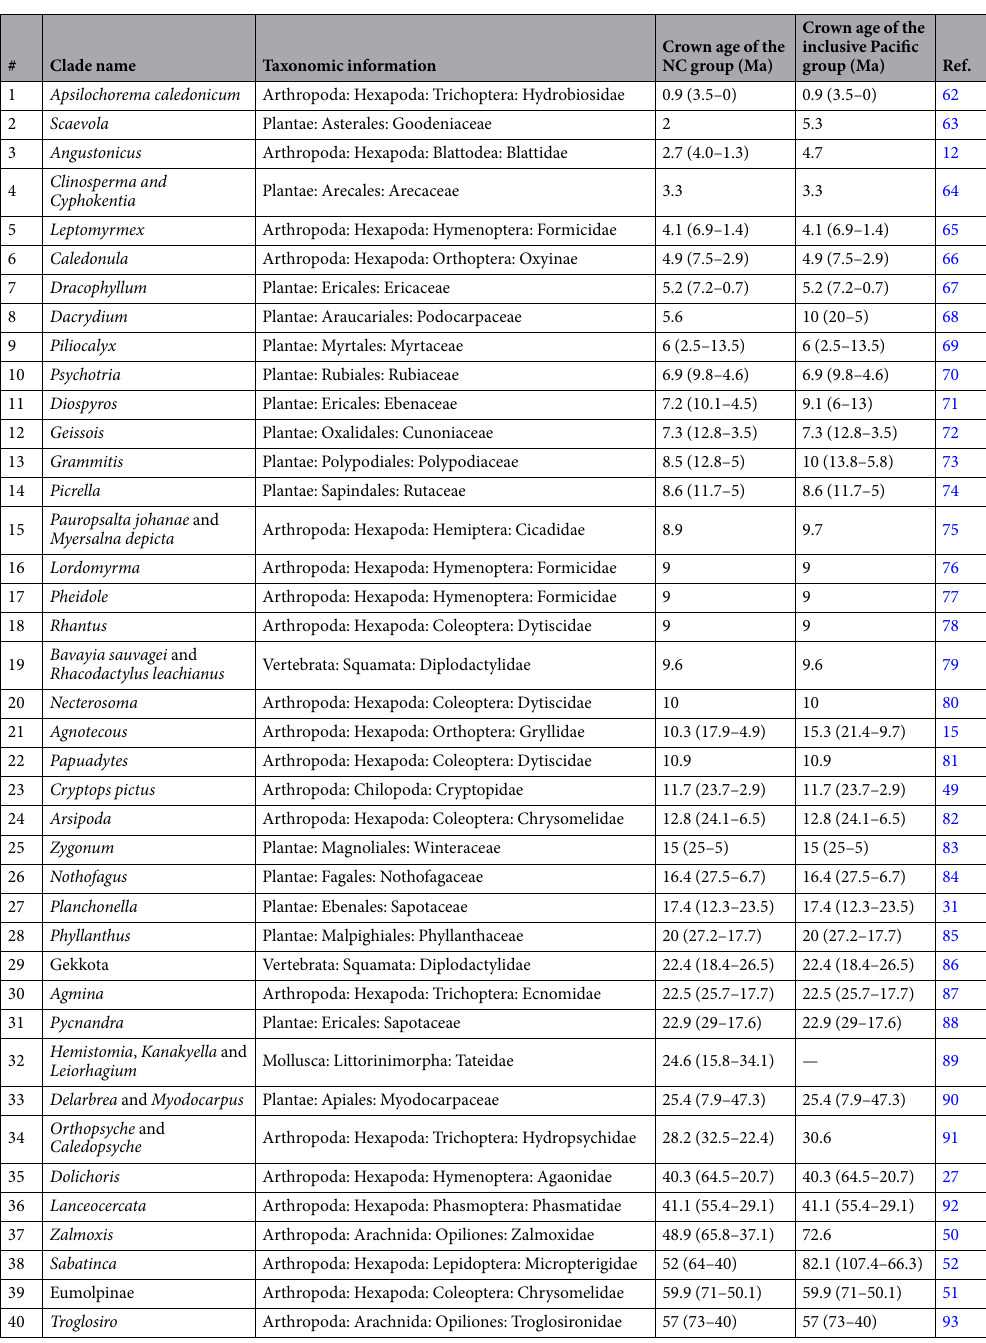
Table 1. Details of the studies included in this review: taxonomical information, divergence age estimates for NC crown group and inclusive Pacific crown group, and reference